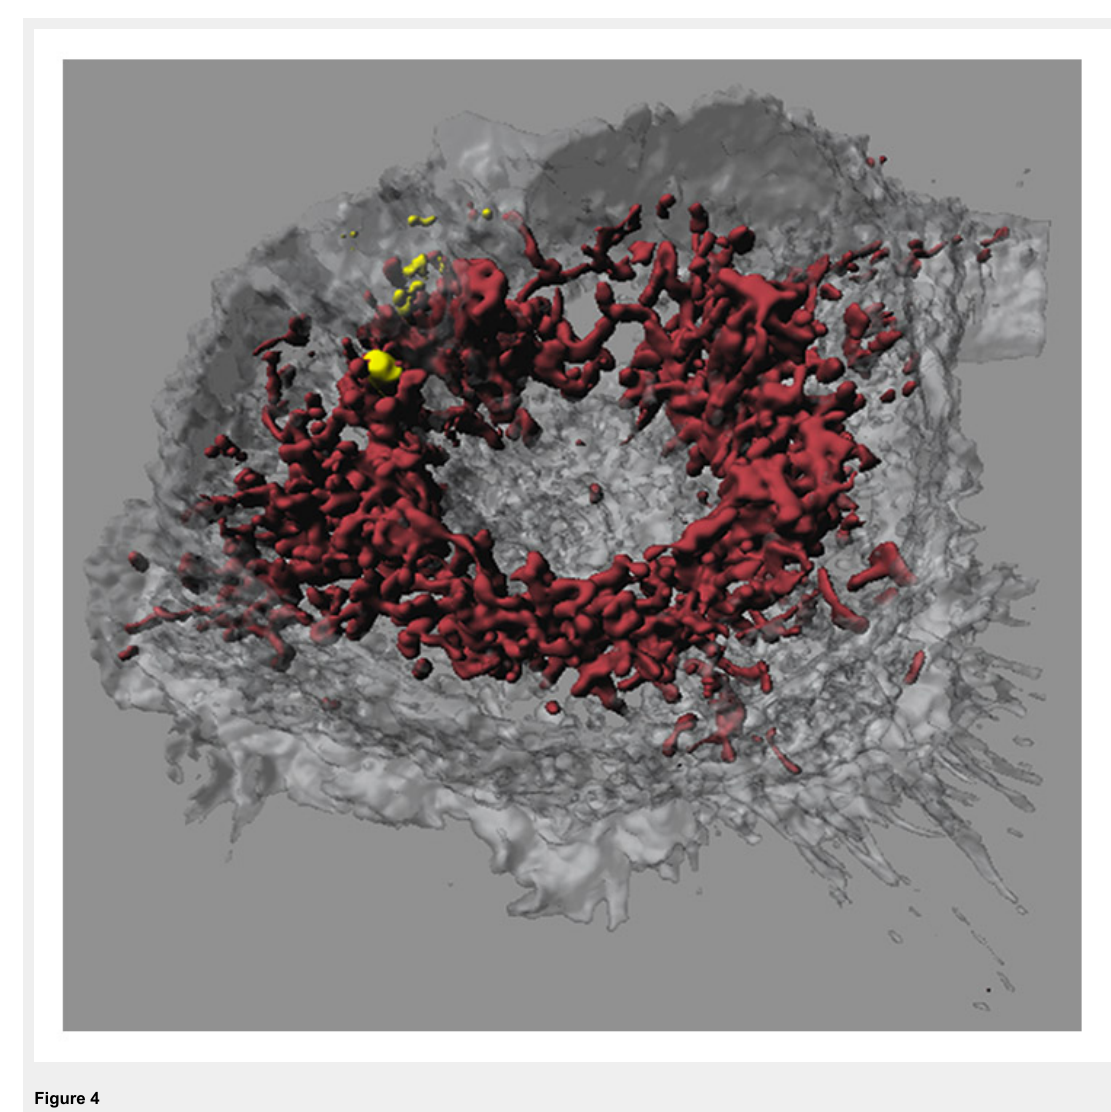
Figure 4 Confocal laser scanning microscopy image of a macrophage that had taken up iron-platinum nanoparticles. Fluorescent labelling of mitochondria using MitoTracker (bordeaux) reveals that the fluorescently labelled polymer-coated iron-platinum nanoparticles (yellow) do not colocalise with mitochondria in macrophages (white, transparent). Image adapted and reproduced with permission from reference [100].